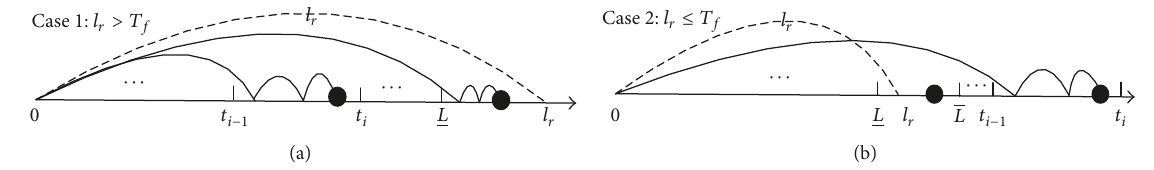
Figure 8: A failure replacement before either defective stage is identified.